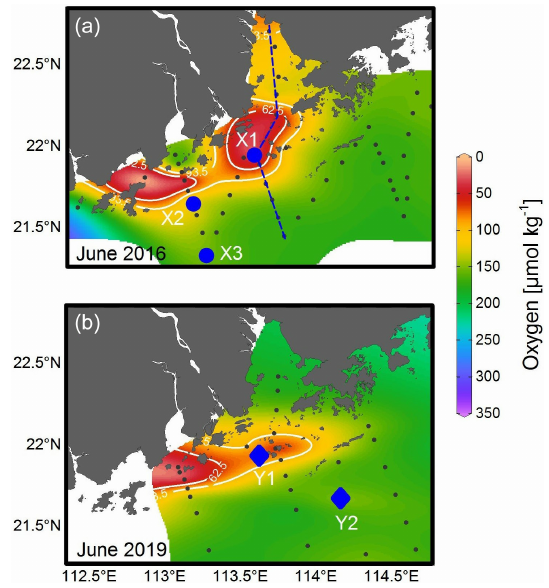
Figure 1. Sampling map of the Pearl River estuary and the ad- jacent northern South China Sea during (a) 17–28 June 2016 and (b) 18 June–2 July 2019. Contour shows the bottom oxy- gen distribution with white lines highlighting the levels of 93.5µmolkg − 1 (oxygen-deficient zone) and 62.5µmolkg − 1 (hy- poxic zone); dashed line in panel (a) is an estuary-to-shelf tran- sect with blue dots for three stations with bacterial metabolic rate measurements; diamonds in panel (b) are two stations with verti- cal pPUA and dPUA measurements, with Y1 being the station for PUA-amended